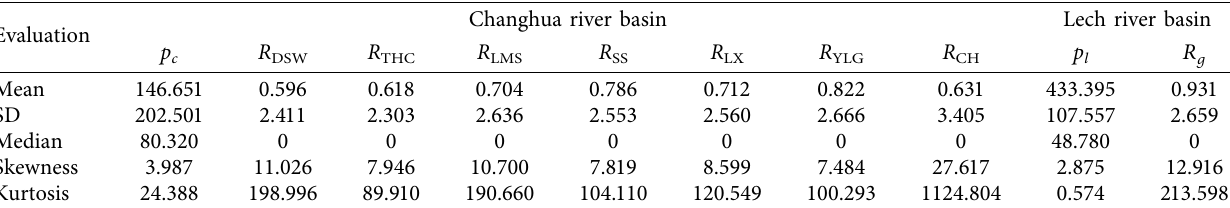
Table 1: Descriptive statistics of daily flow and relevant data for Changhua and Lech dataset, where evaluation SD refers to standard deviation and p and R represent flow rate values and rainfall values, respectively. It is noted that subscripts c and l refer to gauging stations in Chuanghua and Lech River, respectively; subscript g refers to mean evaluation on basin areas of Lech river; subscripts DSW, THC, and other abbreviations represent names of rainfall stations for Changhua dataset. Note that unit for p is defined as m 3 /s and units for R is settled as mm/h.